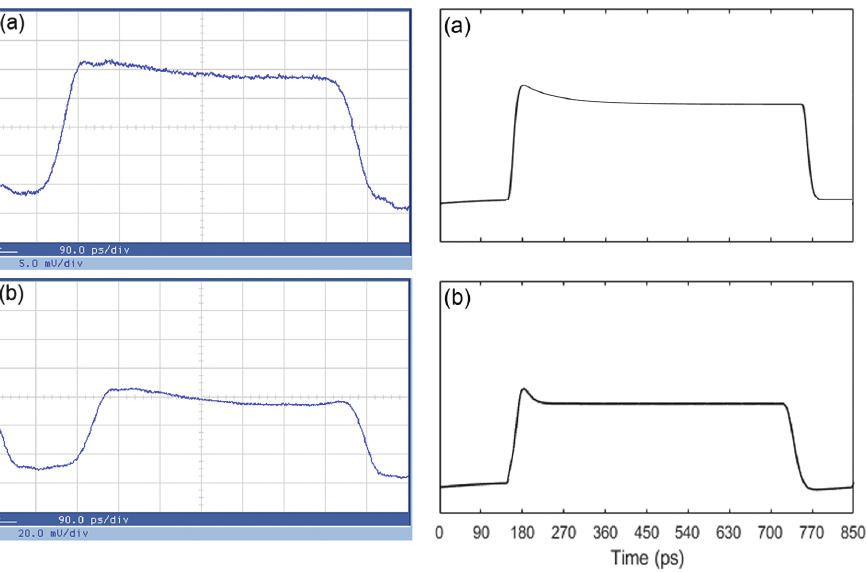
Figure 8. Consecutive “1”s profile at ( a ) output of unsaturated RSOA, ( b ) output of BFL following saturated RSOA. Left column: experimental results. Right column: simulation